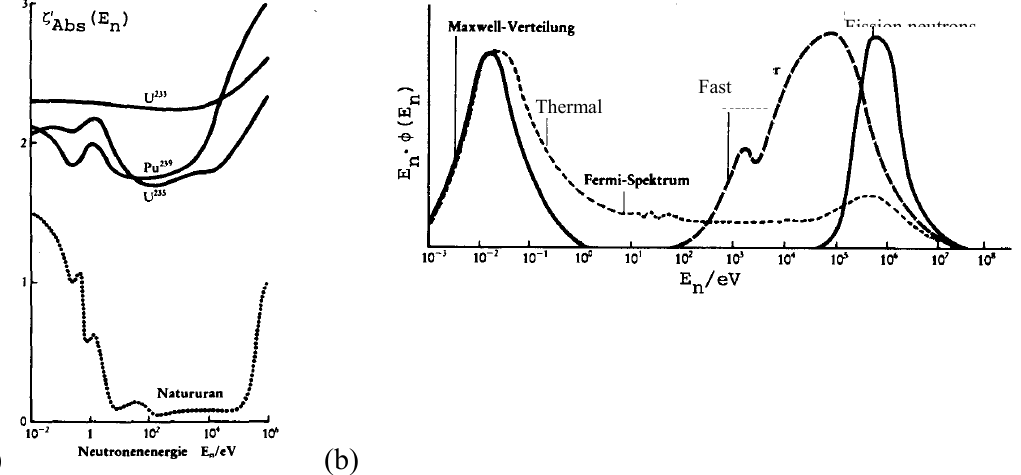
Figure 30. (a) Energy spectrum of thermal, fast and fission neutrons. (b) Neutron yield (y-axis as a function of neutron energy (x-axis). The faster the incident neutrons, the more fission neutrons are obtained from fission. Natururan = natural uranium (after [150]). © 1984 Oldenbourg Verlag, reproduced with permission from [150].